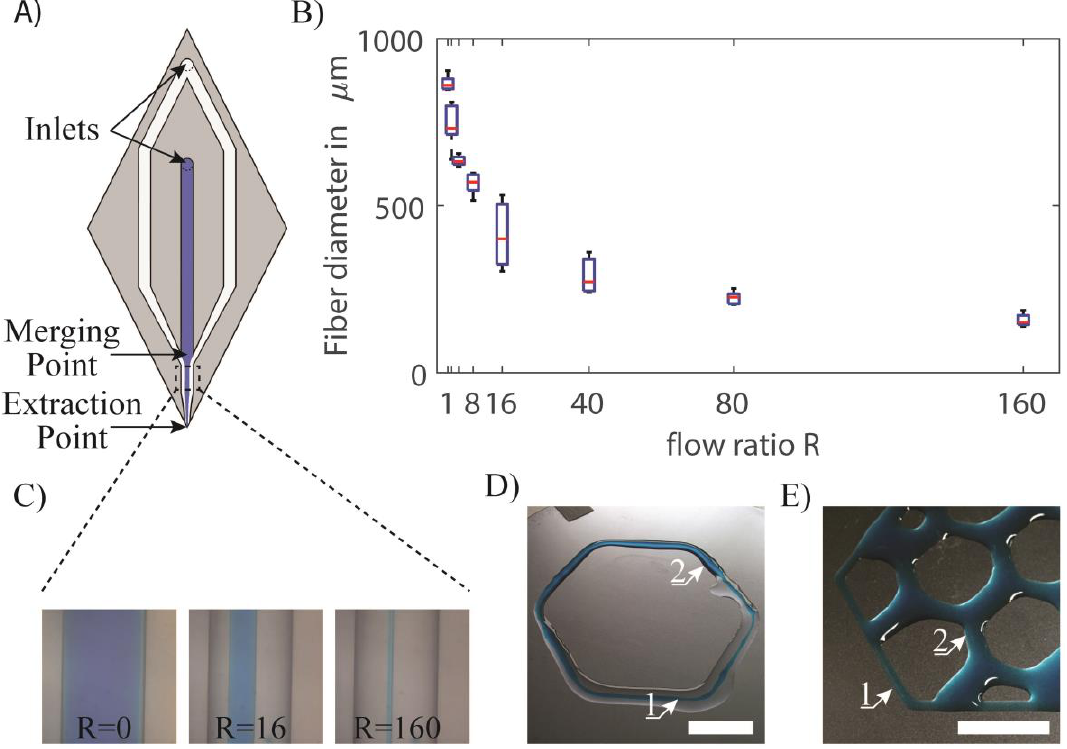
Figure 2. Print head based on flow focusing. ( A ) Principle of hydrodynamic flow focusing with the core flow in blue and the sheath flow in white. ( B ) Flow focusing at different sheath flow/core flow ratios (R). ( C ) Printed fiber diameter as a function of the flow ratio. ( D ) Printed filament going from small filament (1) to large filament (2) whilst the ratio R is changed. ( E ) First layer of a printed part with fine edge (1) and coarse filling (2). Scale bars = 5 mm.